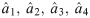
Identification of unknown parameters of systems (12) and (13).(a) a^1, a^2, a^3, a^4 ; (b) b^1, b^2, b^3, b^4 .